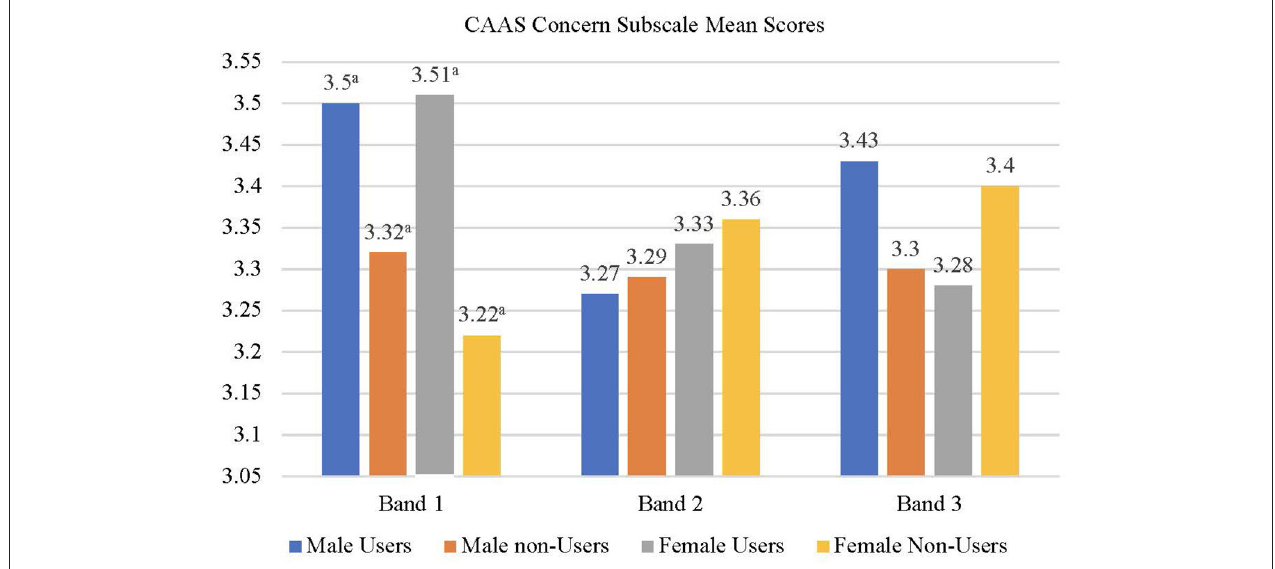
FIGURE 2 | User status × school banding interaction of the CAAS—concern subscale. N = 2,935 12th graders (1,549 females and 1,374 males, 12 unidentified; 844 users and 2,091 non-users). CAAS, Career Adaptability Scale. Scores ranged from 1 to 5 with higher scores indicating higher level of adaptability resources. a Users from band 1 schools had significantly higher scores than non-users from the same banding ( p < 0.001).